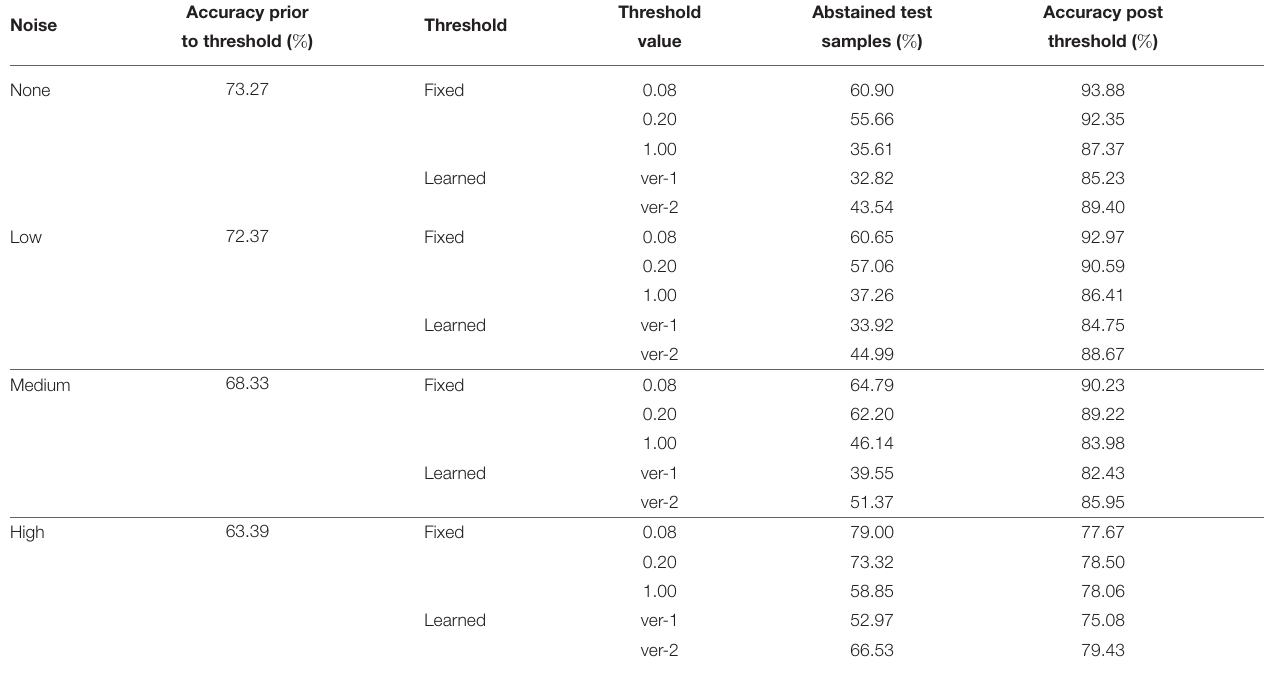
TABLE 6 | Detection of failure in BDNNs—DermaMNIST dataset tested under various levels of Gaussian noise. Accuracy prior Noise to threshold ( % )